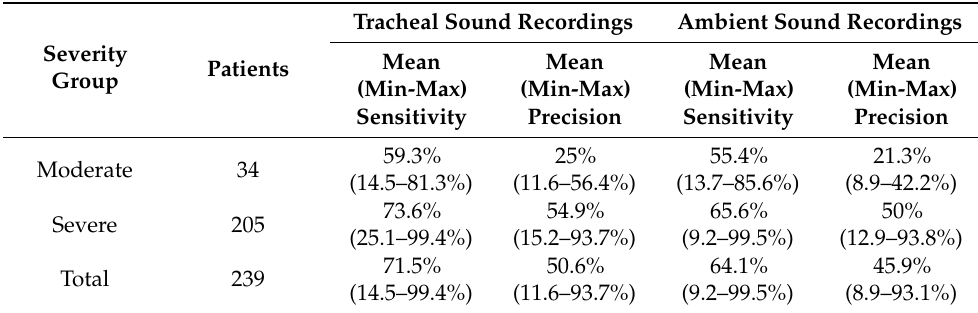
Table 3. The sensitivity and precision per patient with the additional information of the severity group in which they belong based on the delivered apnea diagnosis.